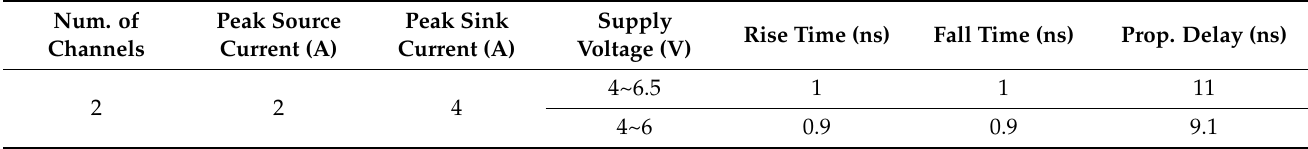
Table 23. Commercial GaN HEMT drivers by pSemi.